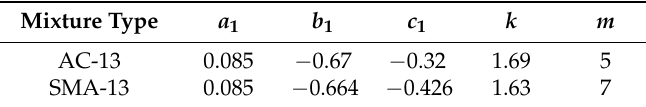
Table 5. Parameters of the simplified nonlinear failure criteria.